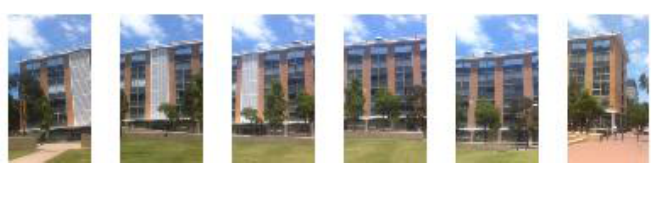
Figure 7. Image space created for P including façade images of Building No.